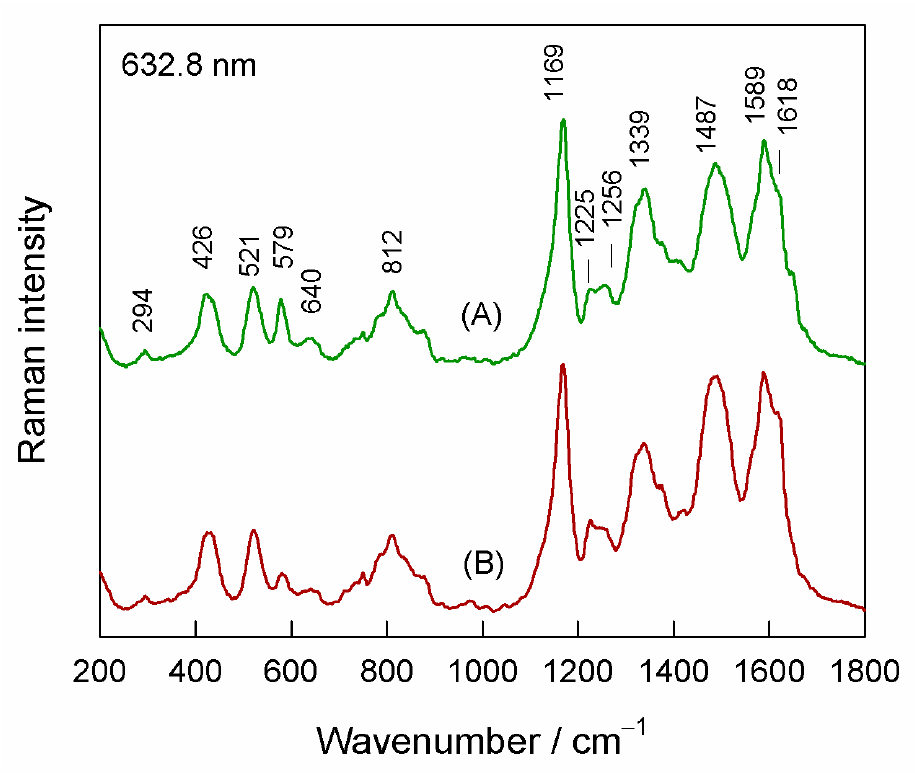
Figure 4. Raman spectrum of ( A )–Ti/TiO x /PANI sample and ( B ) Ti/TiO 2 -/PANI sample. Excitation wavelength 632.8 nm (0.1 mW).